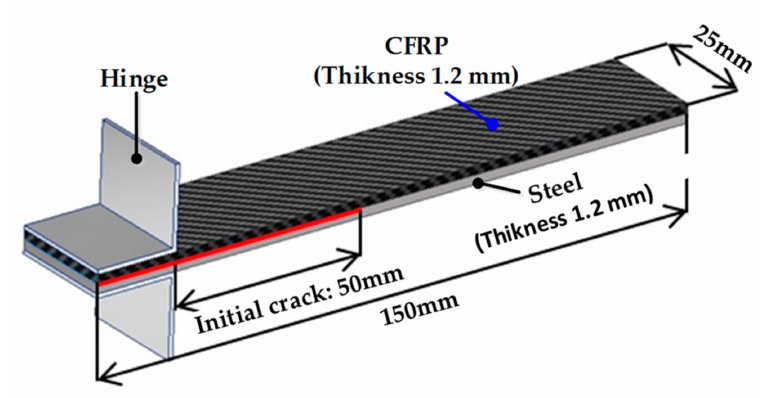
Figure 1. Dimensions of specimen for DCB test.